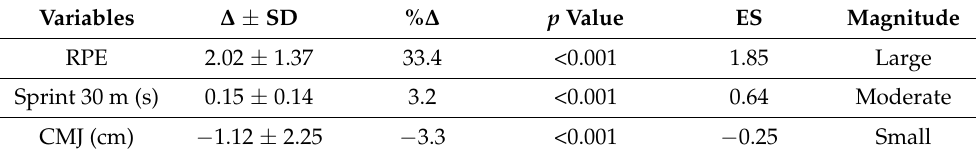
Table 2. Between-moments comparison and changes in the physical performance during official soccer matches.